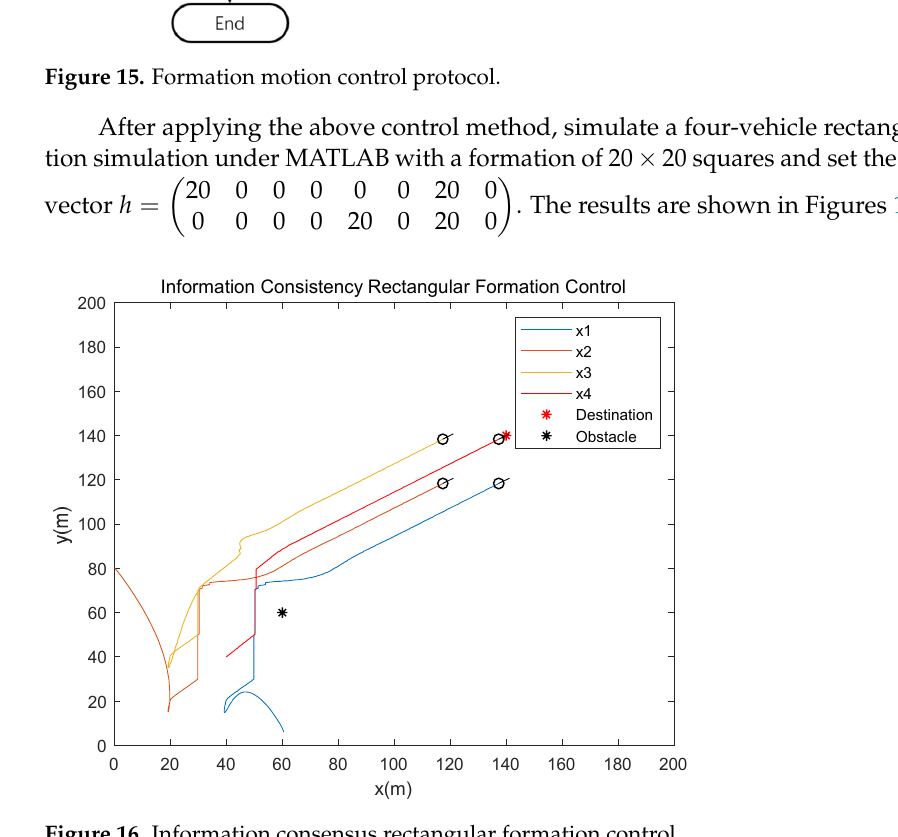
Figure 15. Formation motion control protocol.